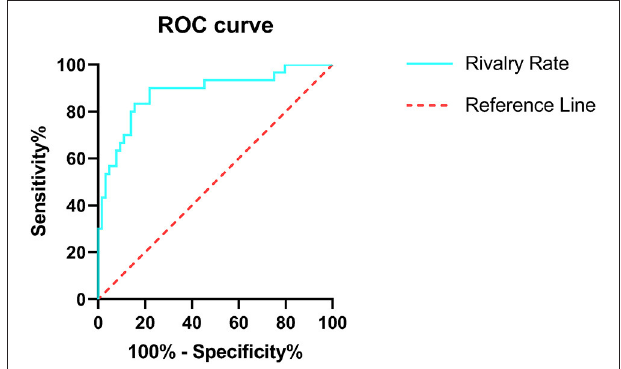
FIGURE 3 | Receiver operating characteristic (ROC) curve of the BR rivalry rate. ROC analysis was used to assess the diagnostic efficiency. The area under the curve (AUC) was 0.881 (95% CI = 0.801–0.961), sensitivity 90.00%, specificity 76.90%, and YI was 0.681. The ROC curve is shown in green and the reference line in